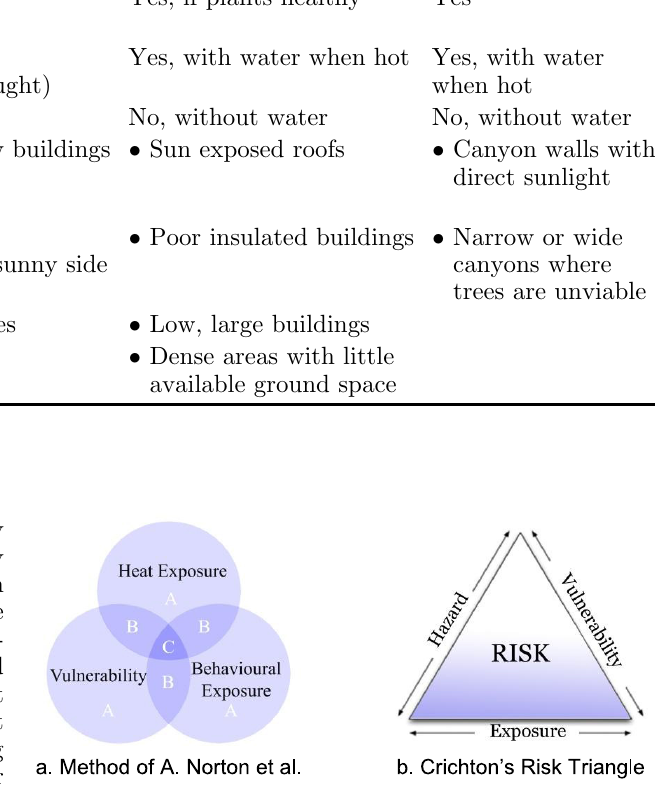
Fig. 4. Mapping the relationship between variables that affect the prioritisation of areas.